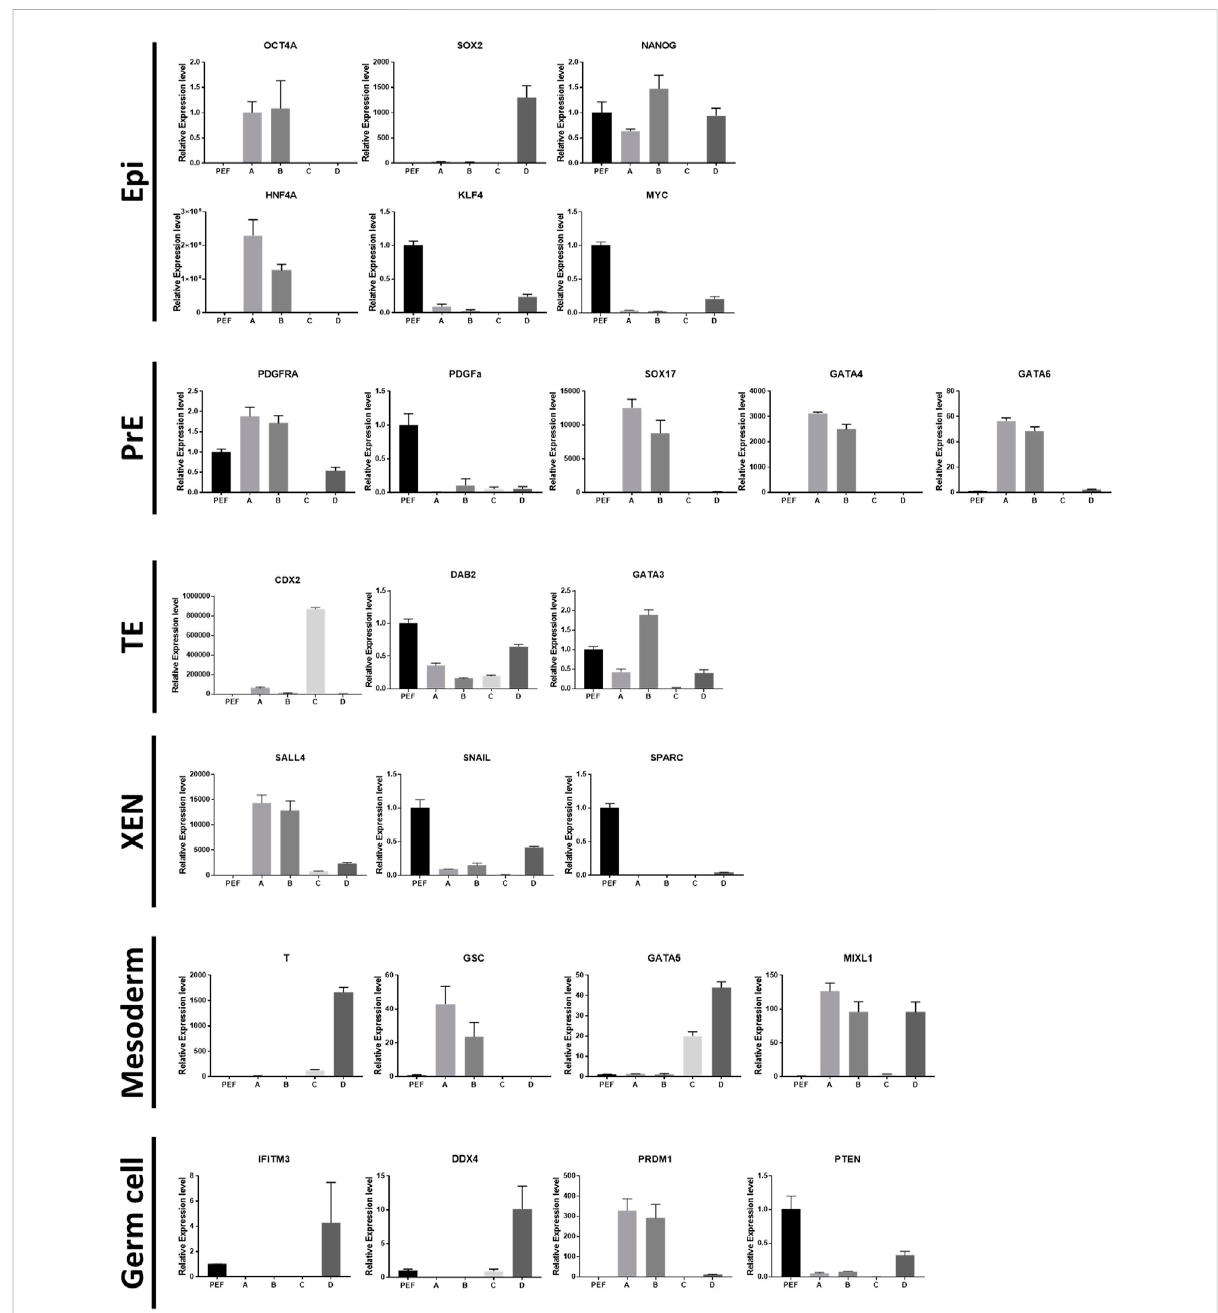
FIGURE 2 Relativeexpressionlevelsoflineagemarkergenes.Epiblast:OCT4A,SOX2,NANOG,HNF4A,KLF4,MYC.Primitiveendoderm:PDGFRA,PDGFA, SOX17, GATA4, GATA6. Trophectoderm: CDX2, DAB2, GATA3. Extraembryonic endoderm cells: SALL4, SNAI1, SPARC. Mesoderm: T, GSC, GATA5, MIXL1. Germ cells: IFITM3, DDX4, PRDM1, PTEM.